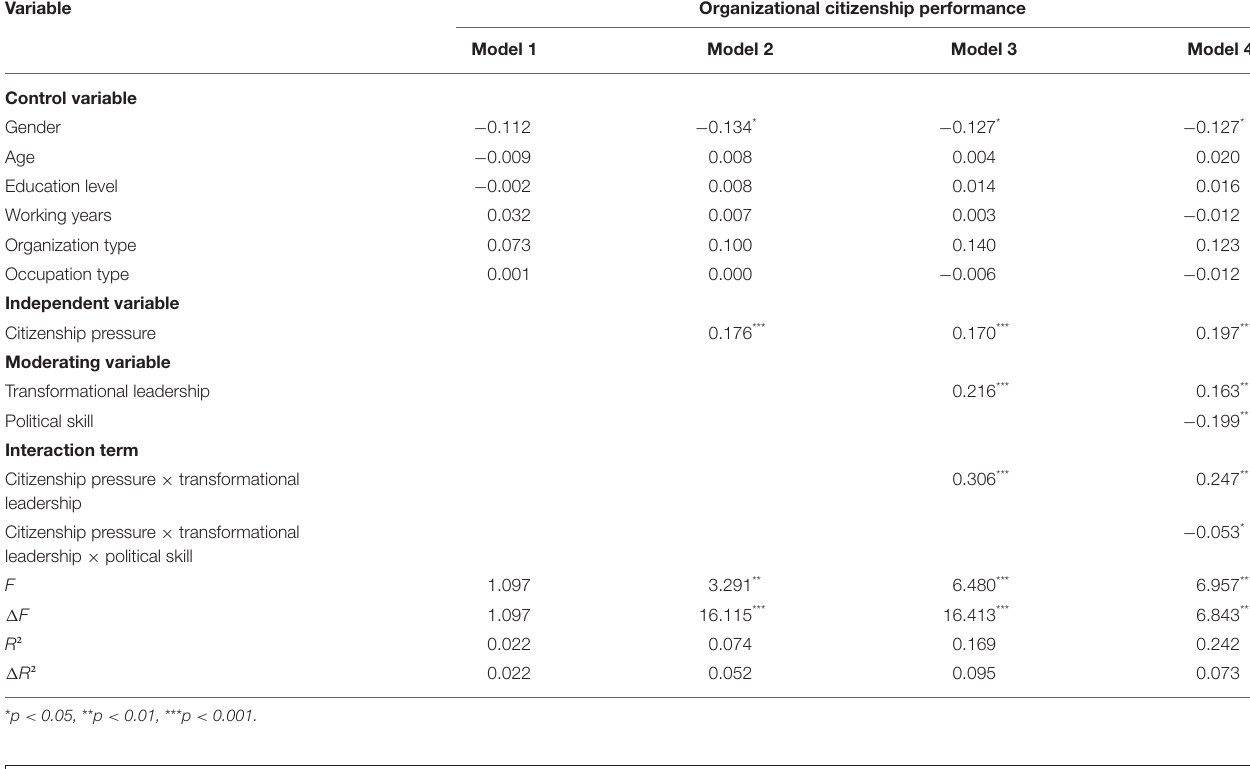
TABLE 5 | Regression analysis results.